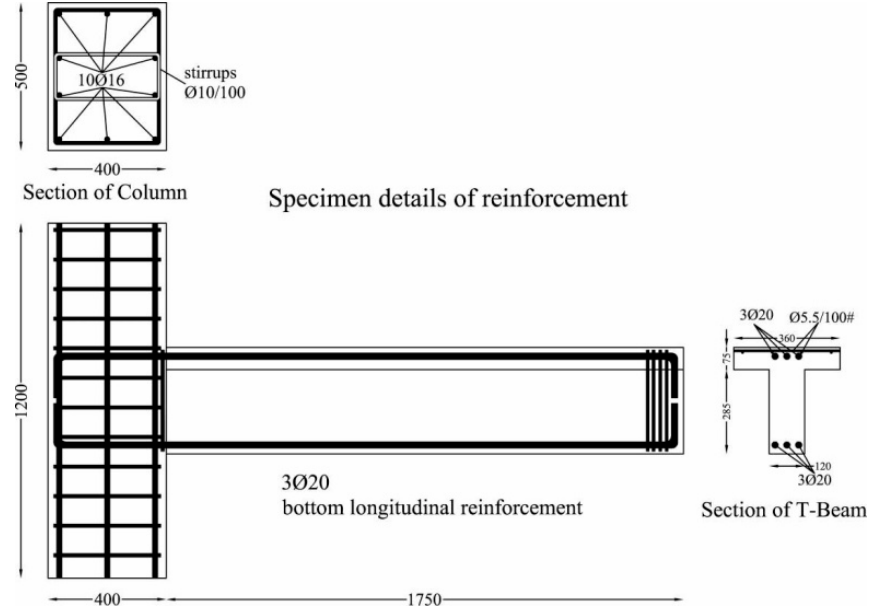
Figure 1. Specimen details and reinforcement.